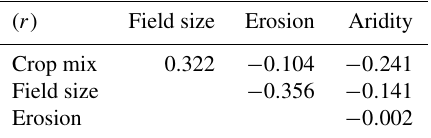
Table 3. Correlation coefficients ( r ) according to Pearson between spatial predictor variables (crop mix, field size, erosion, and aridity) across all grid cells containing potential CA cropland